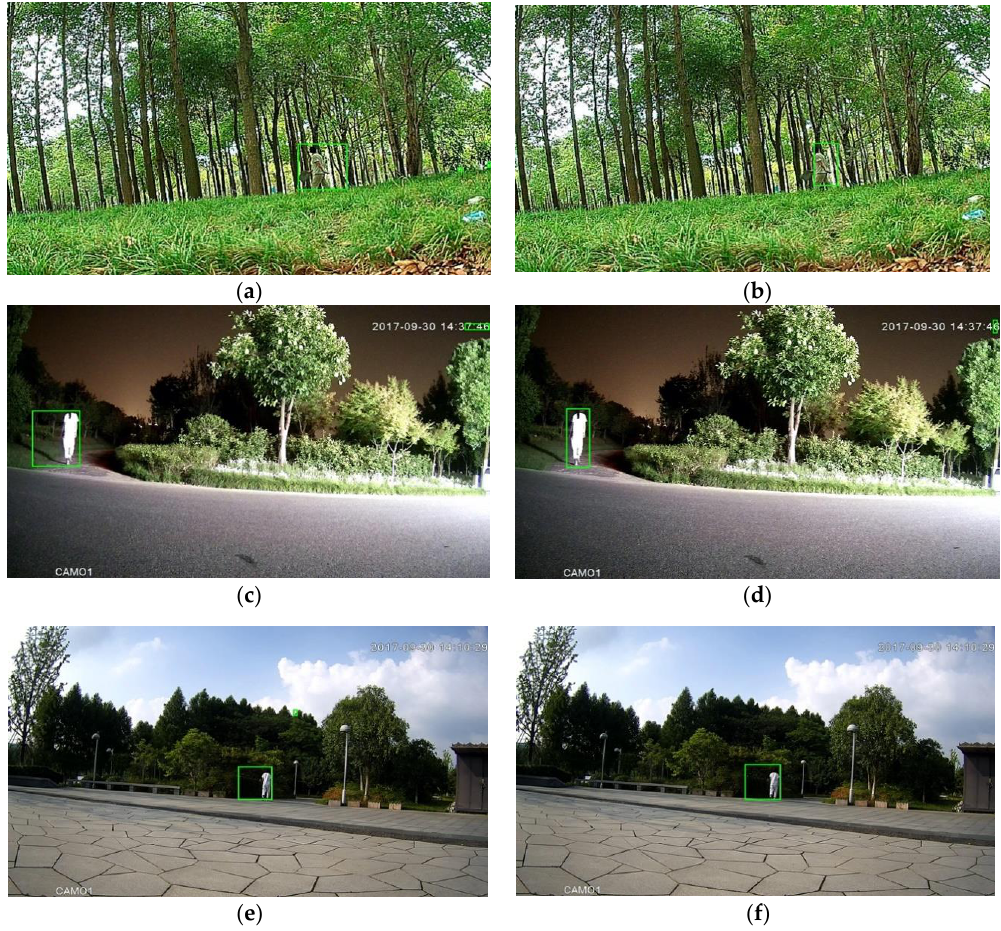
Figure 2. Outcomes of the coarse-grained detection without downsampling ( a,c,e ) and with downsampling ( b,d,f ). The left column and right column correspond to the same images.